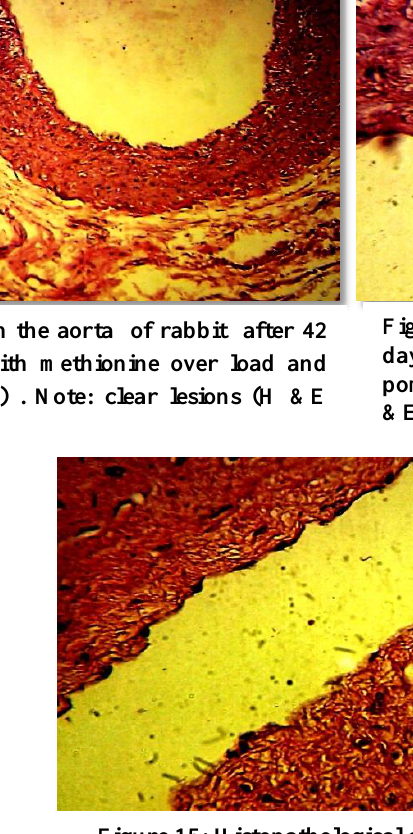
Figure,15: Histopathological section in the aorta of rabbit after 42 day of treatment with pometon (group T3) Note: no clear lesions (H &E stain